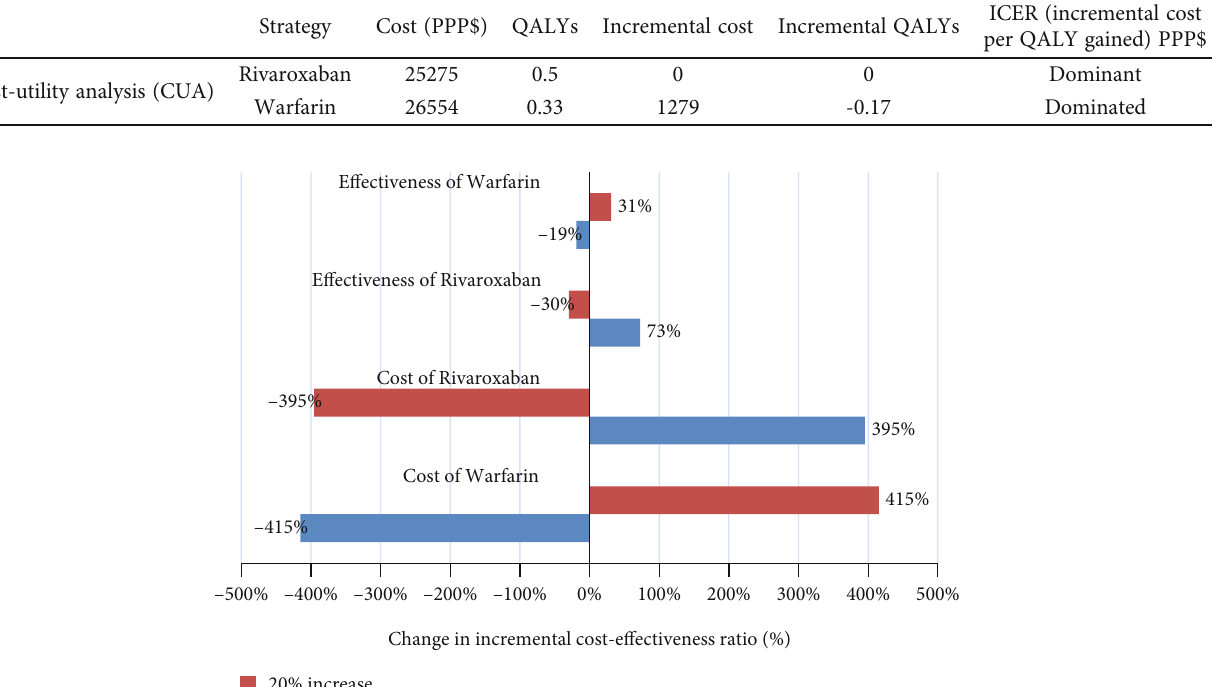
Figure 1: Tornado diagram of cost-e ff ectiveness to prevent of bleeding for patients with AF under treatment with rivaroxaban and warfarin.